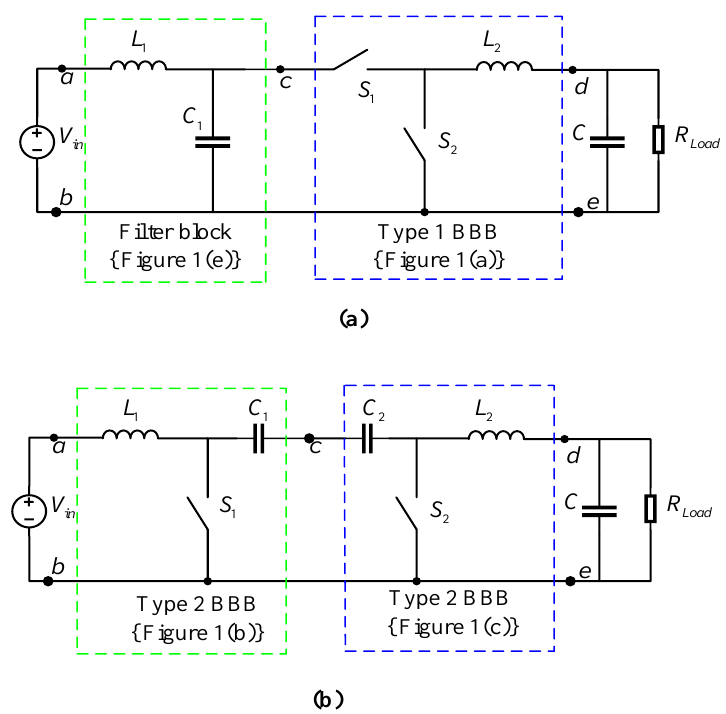
Figure 2. Example converters. ( a ) a buck converter with input filter, and ( b ) a Cuk converter. Table 1. Converters considered in the study.